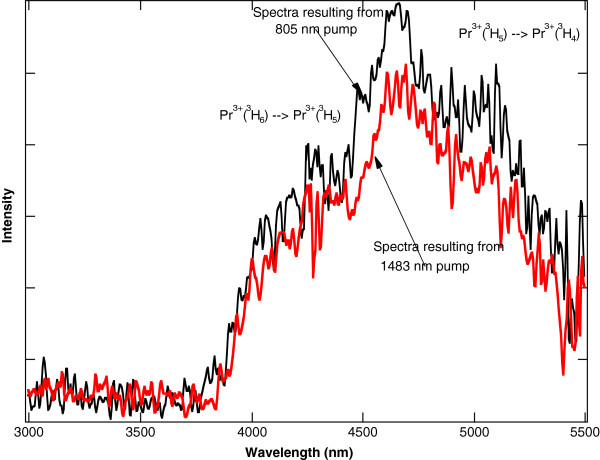
Fluorescence from 3,000 to 5,500 nm from Tm3+-Pr3+:KPb2Cl5. Fluorescence resulting from 1,483-nm pumping of Tm3+-Pr3+:KPb2Cl5 compared to fluorescence resulting from 805-nm pumping. The sample has a Pr3+ concentration of 1.5 × 1020 ions/cm3 and a Tm3+ concentration of 3.0 × 1020 ions/cm3.